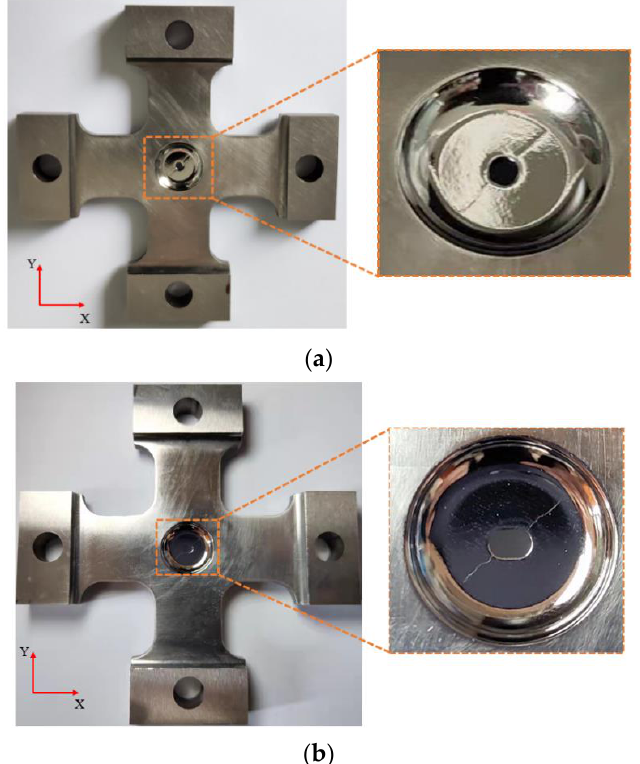
Figure 8. Final failure diagram of cruciform specimen. ( a ) Cruciform specimen with circular notch in the central area. ( b ) Cruciform specimen with 0° waist circle hole notch in the central area.